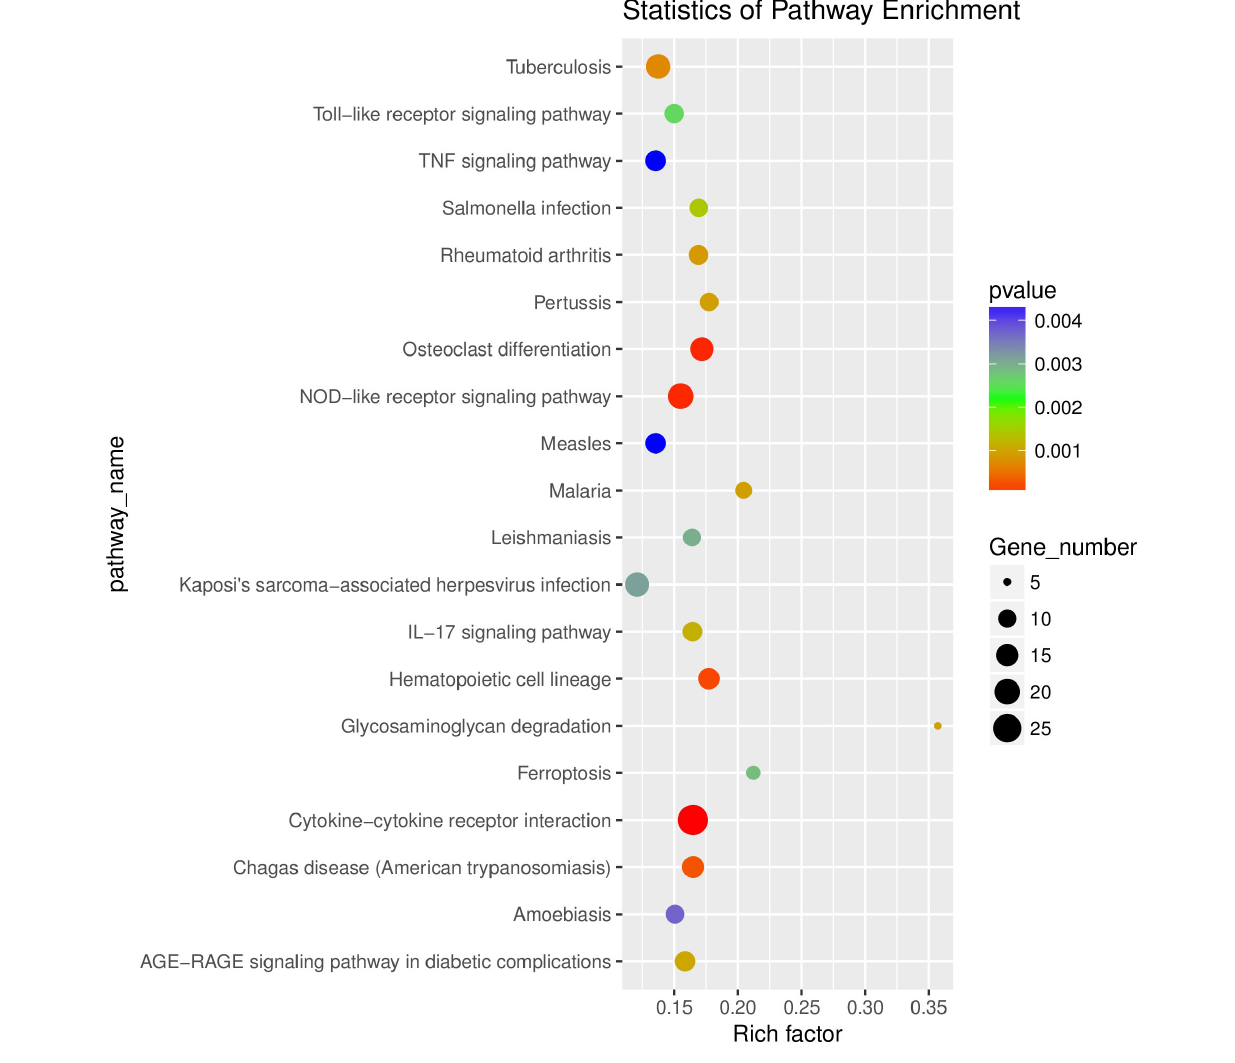
FIGURE 7 | Scatter plot of KEGG enrichment of differential genes. The abscissa Rich factor indicates the number of differential genes located in the KEGG/the total number of genes located in the KEGG. The ordinate is Pathway term, that is, KEGG metabolic